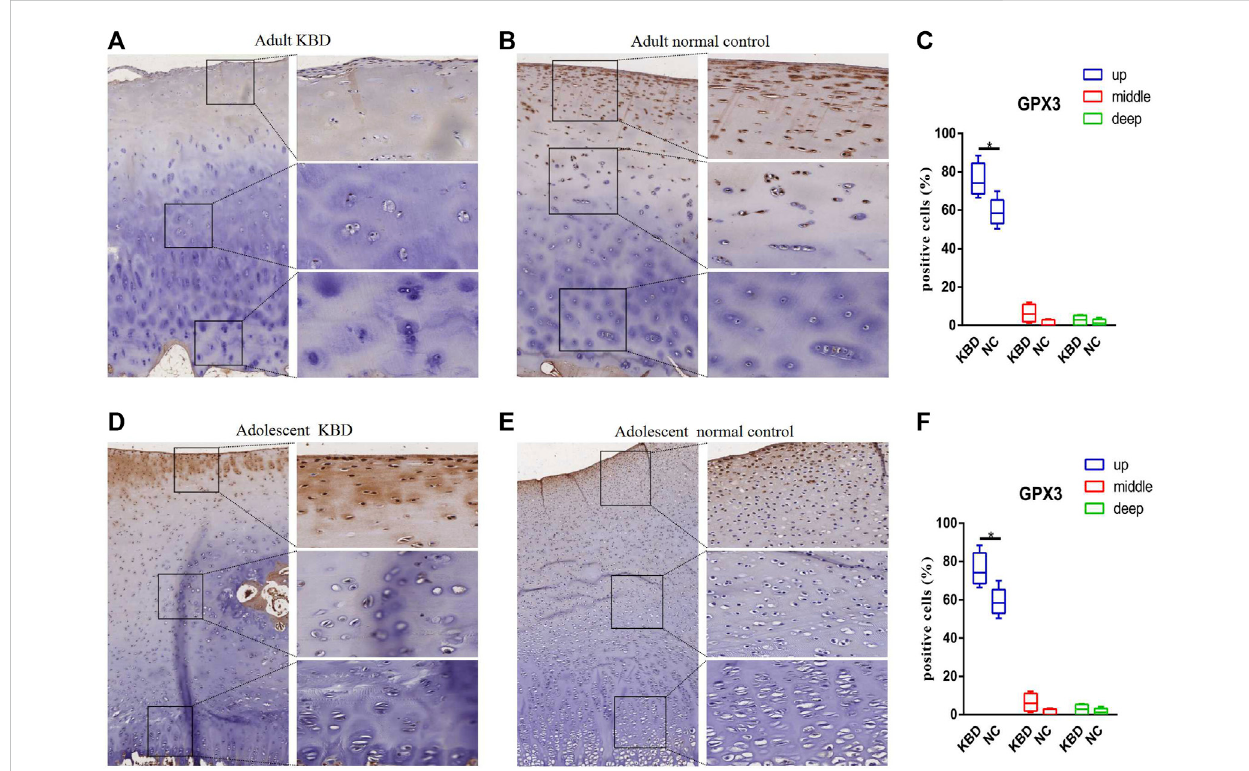
FIGURE 3 Representative immunohistochemistry staining of GPX3 in adult KBD (A) , adult normal control (B) , adolescent KBD (D) , and adolescent normal control (E) cartilagetissues(scalebar:left,500 μ m;right,100 μ m)andcomparativequanti fi cationofpositivecellsofdifferentareas(up,middle,anddeep) in adult (C) and adolescent (F) cartilage tissues displayed by a box plot ( n = 3). * p < 0.05.